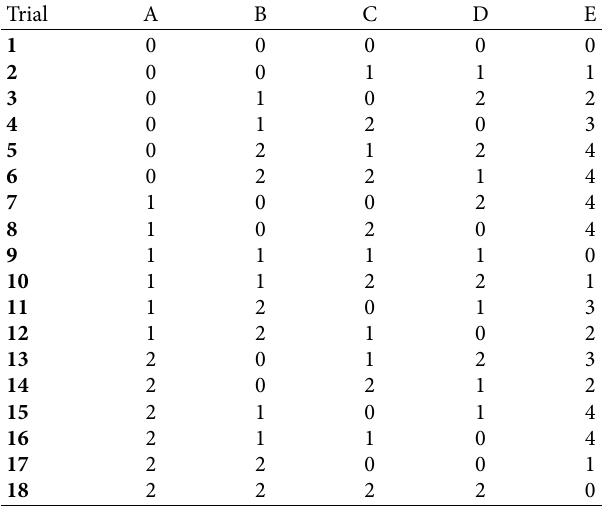
Table 4: Modified array L18 for particle mass optimization